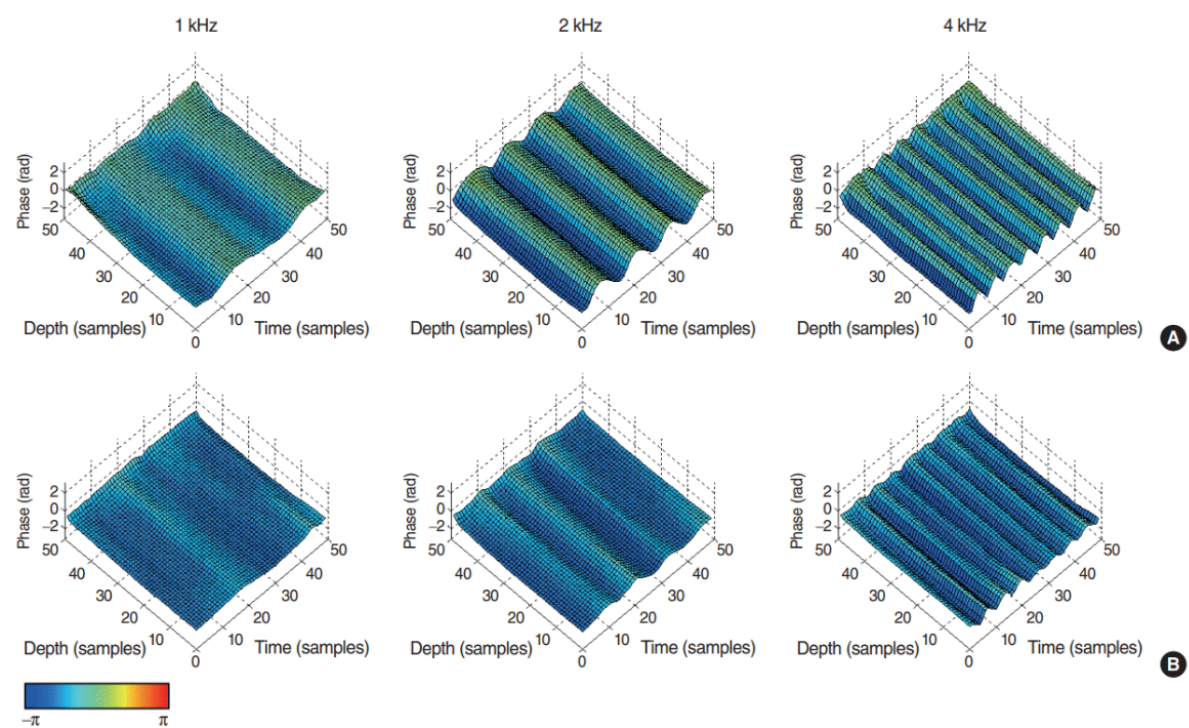
Figure 6. Three-dimensional reconstruction images of the detected phase shift on the contact area between tympanic membrane (TM) and malleus in ( A ) normal TM and ( B ) simulated effusion condition stimulated by 1 kHz, 2 kHz, and 4 kHz pure tone stimuli. Reprinted with permission from Ref. [66] .